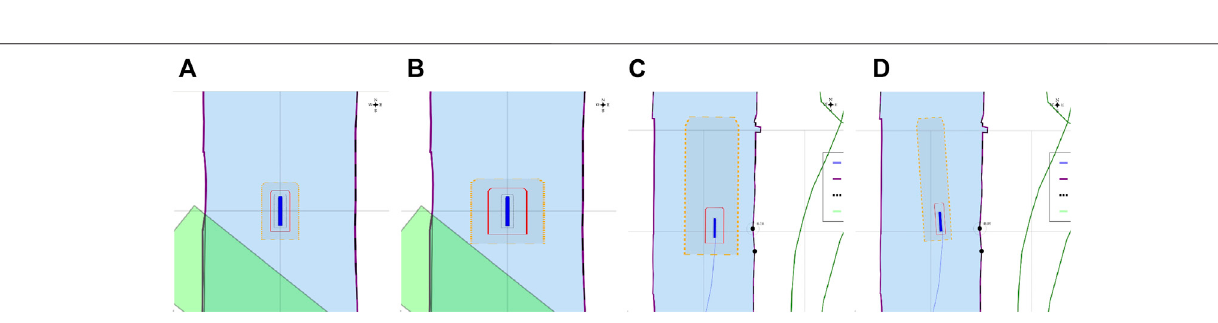
FIGURE 10 | Dynamically allocated tolerances to SD1 and SD2 via a main geometry – motion relation (with hydrodynamical model of the vessel), both for a static vessel (A,B) and a moving vessel (C,D) .